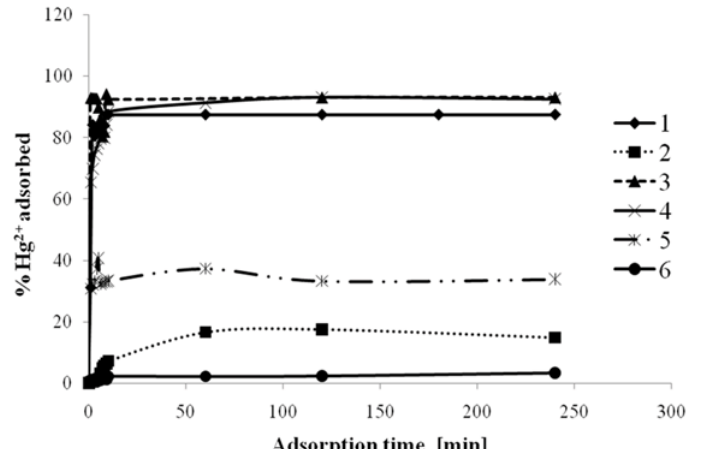
Figure 5. Effect of sulfide at different pH on Hg 2+ adsorption (agitated system, 20 g of ZL 1606 sediment, 250 mL of water, Hg concentration 0.2 mg L -1 , T = 22.3°C) ; (1) pH 5.2, without sulfide, (2) pH 5.2, 0.2 g L -1 sulfide, (3) pH 1, without sulfide, (4) pH 1, 0.2 g L -1 sulfide, (5) pH 12, without sulfide, (6) pH 12, 0.2 g L -1